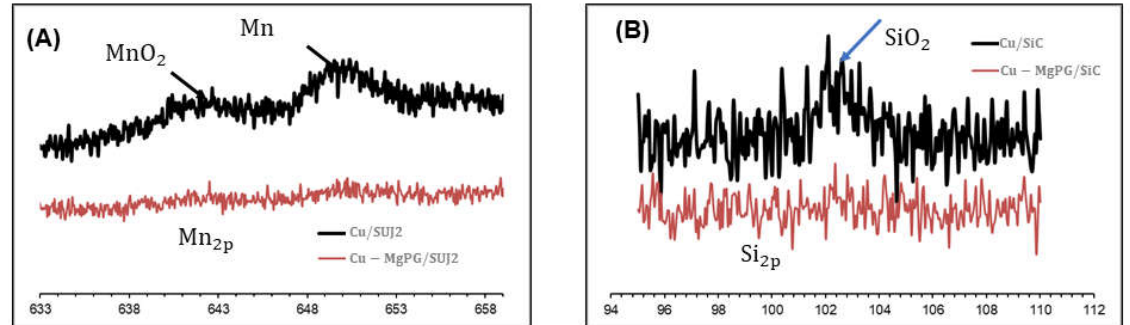
Figure 11. XPS analysis of worn surfaces of sintered copper and Cu-MgPG samples against ( A ) SUJ2 counterbody; ( B ) SiC counterbody.